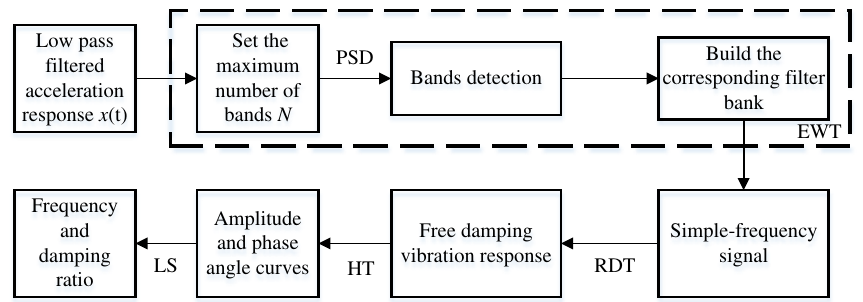
Fig. 11 EWT-HT modal parameter identification